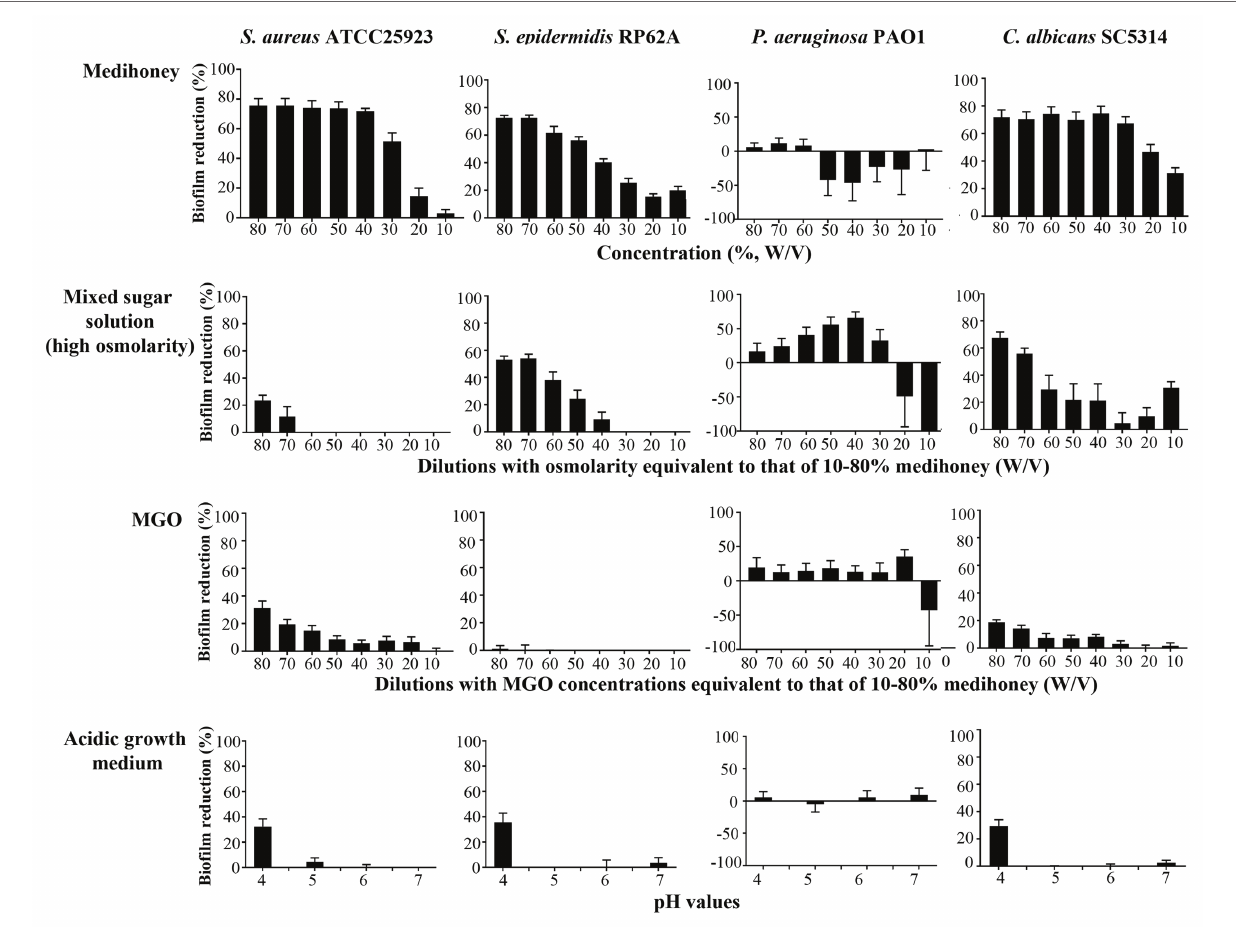
FIGURE 1 | Assessment of the anti-biofilm activity of individual components of MAWG using microplate-based biofilms. Biofilms were established in 96-well microplates and were treated with MAWG solution, mixed sugar solution, methylglyoxal (MGO) solution at different concentrations, and growth media prepared at different pH. 2,3-bis-(2-methoxy-4-nitro-5-sulfophenyl)-2H-tetrazolium-5-carboxanilide (XTT) was used to detect the percentage of survivor biofilm cells after the treatment relative to untreated control. XTT readings at OD 492 for untreated control biofilms were as below: S. aureus ATCC 25923, 0.94 ± 0.09 (mean ± SD); S. epidermidis RP62A, 0.89 ± 0.22; P. aeruginosa PA01, 0.25 ± 0.06, and C. albicans , 2.50 ± 0.50. The ratio of cell survival (OD 492 after antimicrobial treatment) relative to antimicrobial-free culture (OD 492 of the drug-free biofilms × 100) was calculated. Biofilm reduction was calculated as (1-cell survival%). Error bars indicate the standard error of the